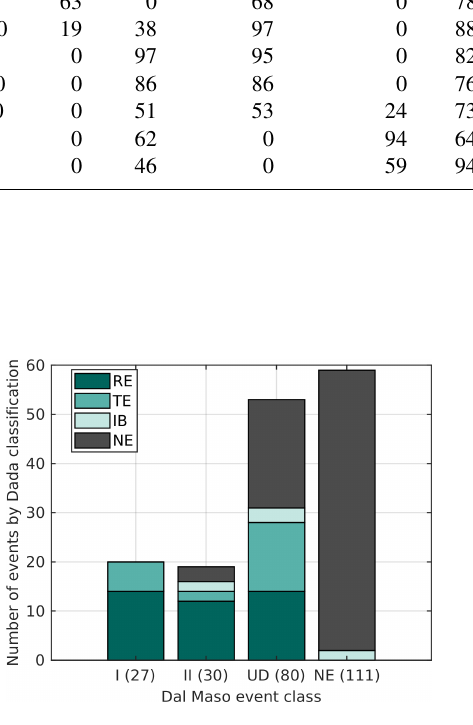
Figure B1. Comparison of the results of two event classification methods. The number in parentheses shows the number of events in each class by the Dal Maso et al. (2005) classification. RE stands for regional events, TE for transported events, IB for ion bursts, and NE for